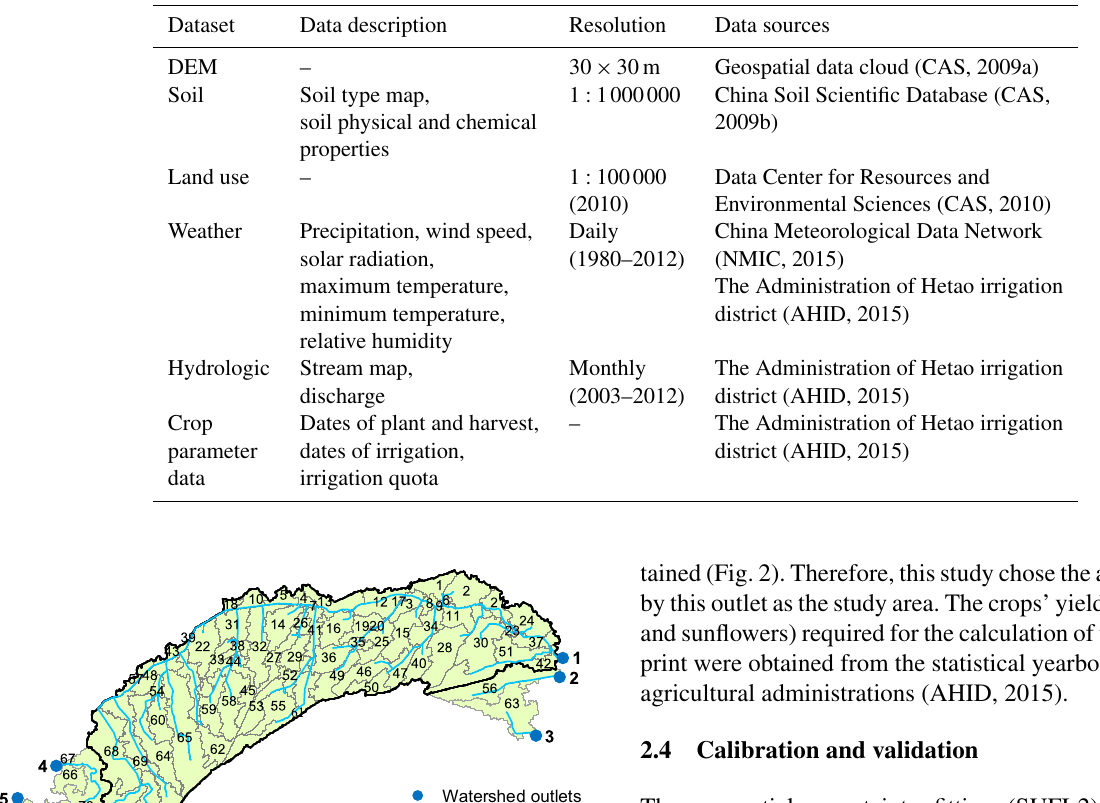
Table 1. Data used in the study and the resources.